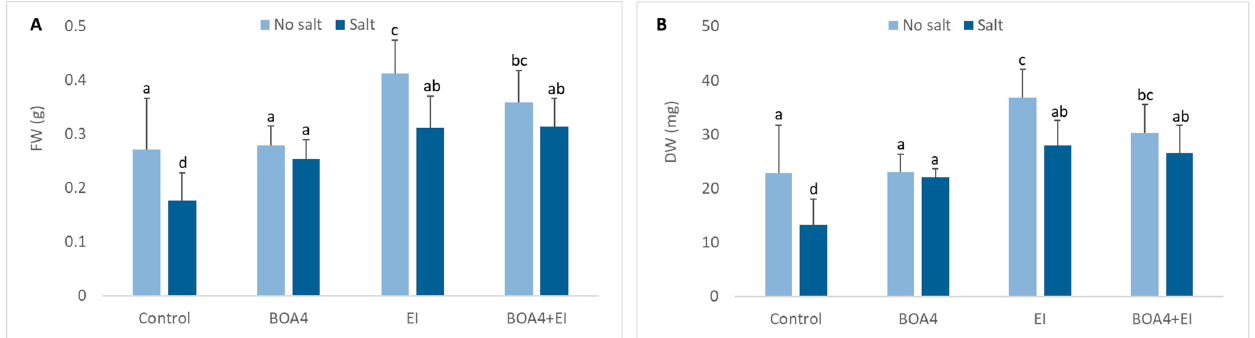
Figure 1. Shoot biomass of plants collected at day 35. Fresh weight (FW) (panel ( A )) and dry weight (DW) (panel ( B )) are depicted. No-salt and salt stress conditions are represented by light-colored and dark-colored columns, respectively. BOA4: Achromobacter xylosoxidans strain BOA4; EI: Enteromorpha intestinalis extract; BOA4 + EI: Achromobacter xylosoxidans strain BOA4 plus Enteromorpha intestinalis extract. Values shown are means and error bars represent standard deviation. Different letters above the bars indicate means that differ significantly ( p < 0.001).